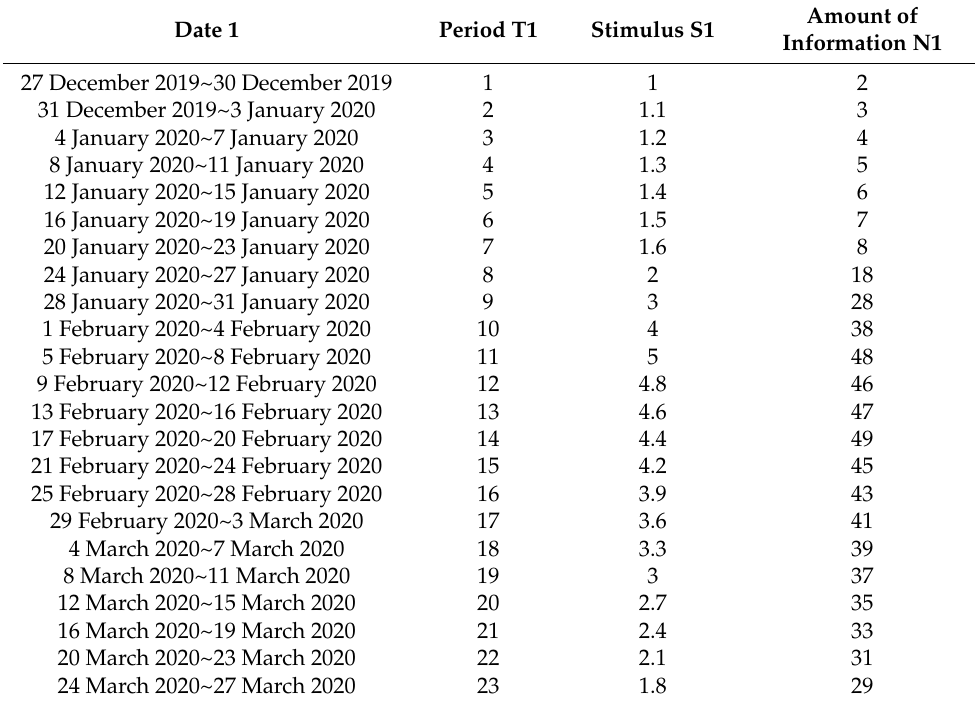
Table 10. Assignment to S and N to the Short Period